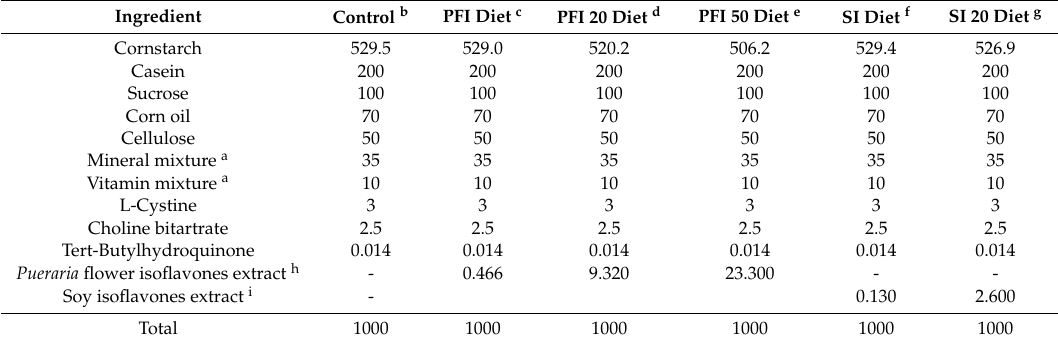
Table 3. Composition of the experimental diets (g / kg diet) a